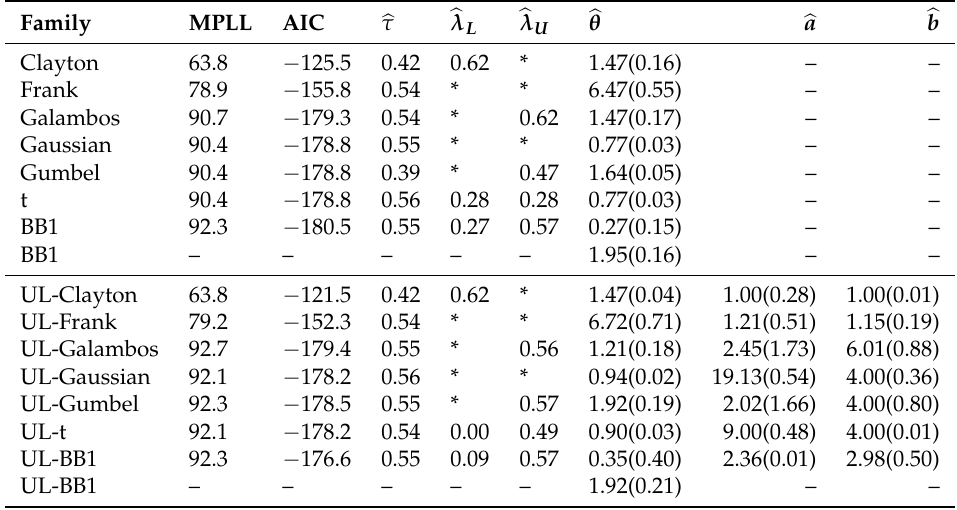
Table 3. MPLL, AIC, ˆ τ , ˆ λ L , ˆ λ U , and parameter estimates (standard error in parentheses) for the base and UL distorted copulas during crisis